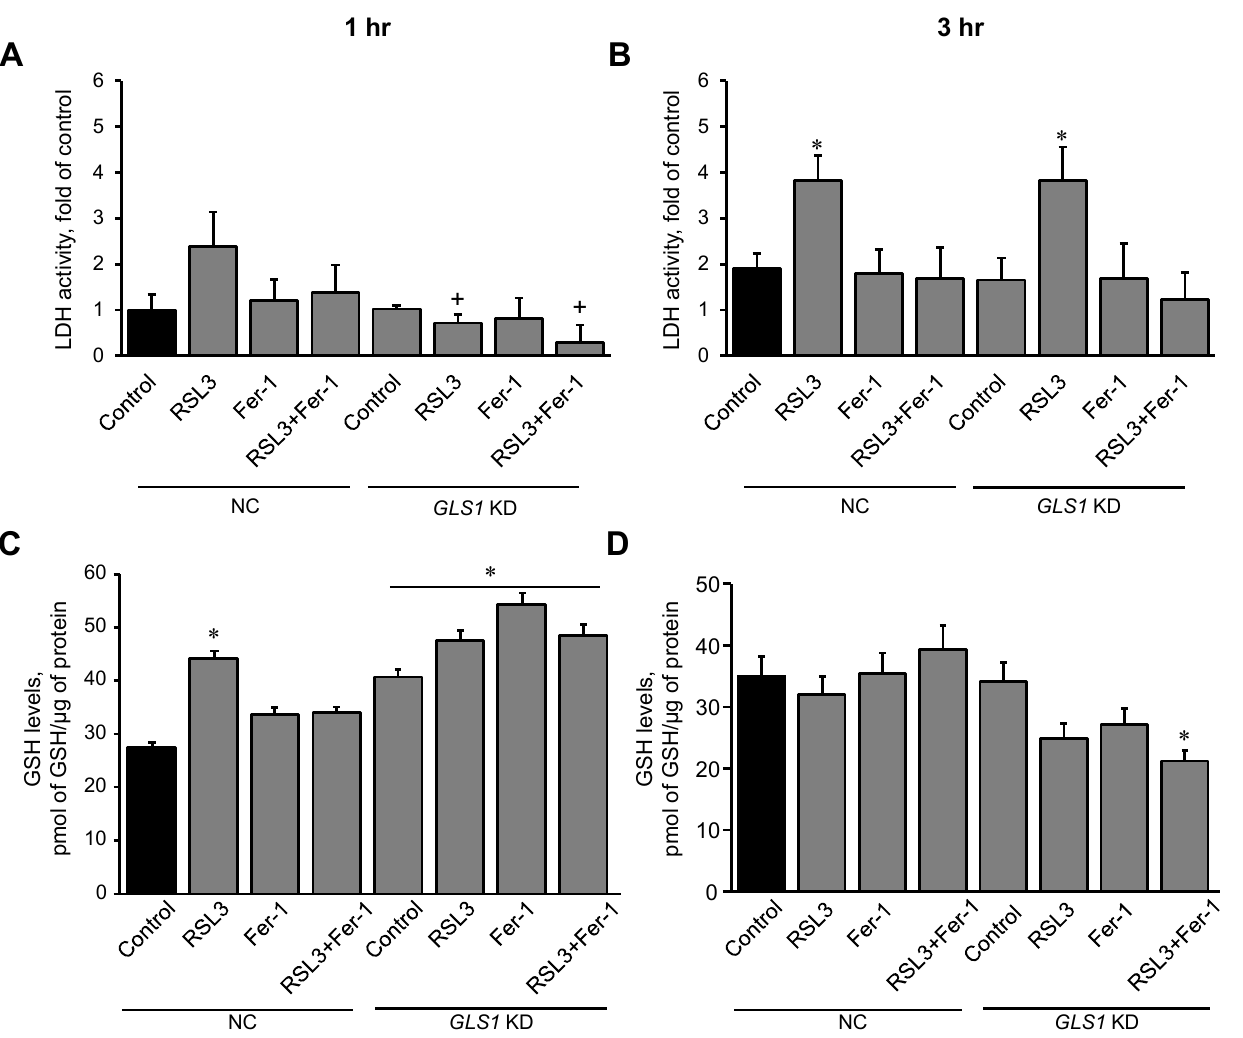
Figure 7. RSL3-induced cell death and GSH levels in GLS1 KD H9c2 cells after ferroptosis. H9c2 cells from non-coding (NC) and GLS KD groups were incubated in the presence and absence of 0.5 µM RSL3, 1 µM Fer-1, or both for 1 ( A ) and 3 h ( B ). LDH activity, as a marker of cell death, was measured in the culture medium containing H9c2 cells. Results were normalized to the control. GSH was quantified in mitochondria isolated from the cells after 1 hr ( C ) and 3 hr ( D ) of incubation. Data were normalized to a standard curve of GSH which ranged 1-10 µM. * p < 0.05 vs. control (NC), + p < 0.05 vs. RSL3 (NC). n = 3 per group.